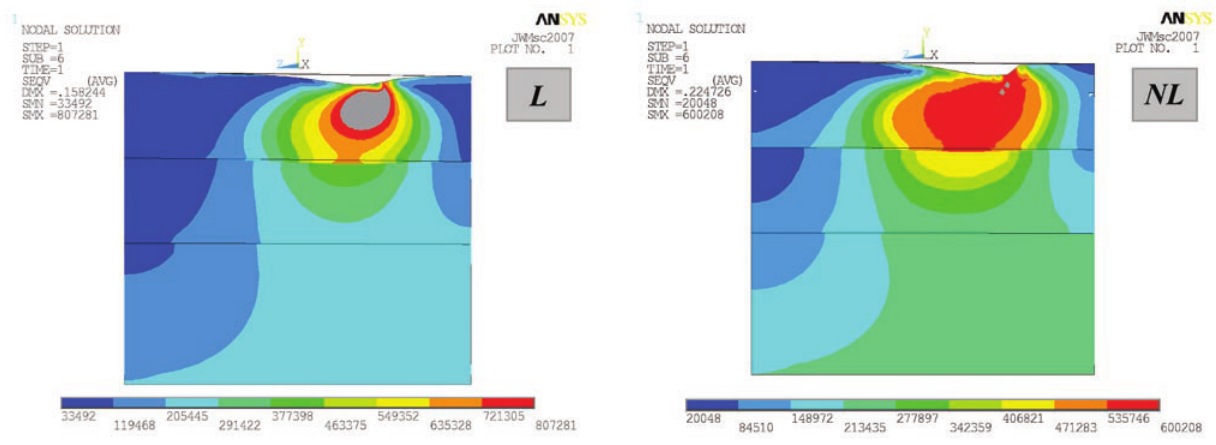
Fig. 10a. Stress intensity contours according to von Mises in the section (nonlinear analysis), Pa